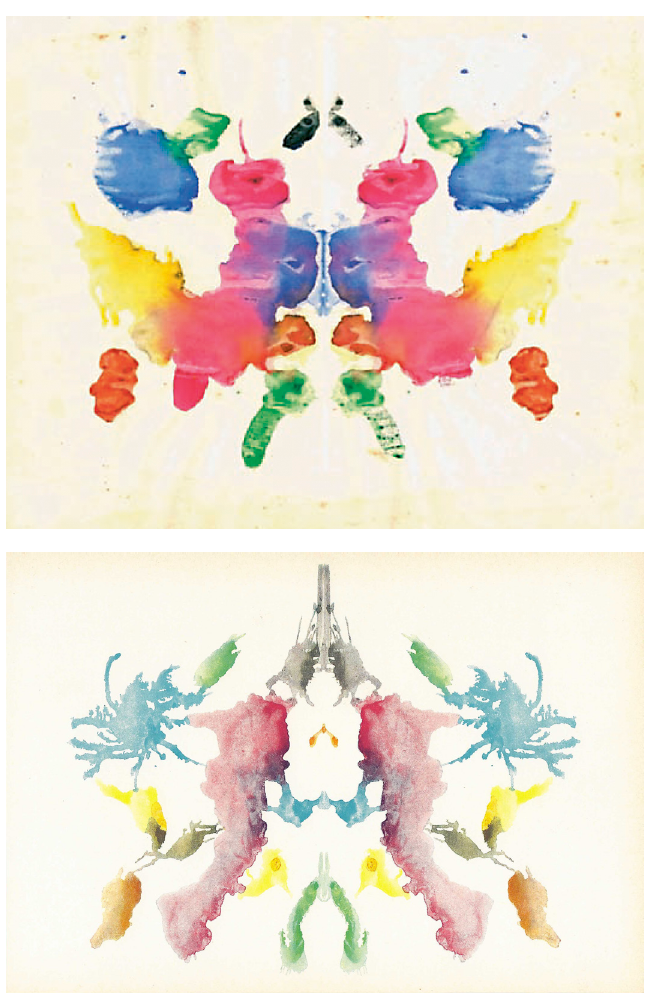
Fig. 1 Hermann Rorschach, early